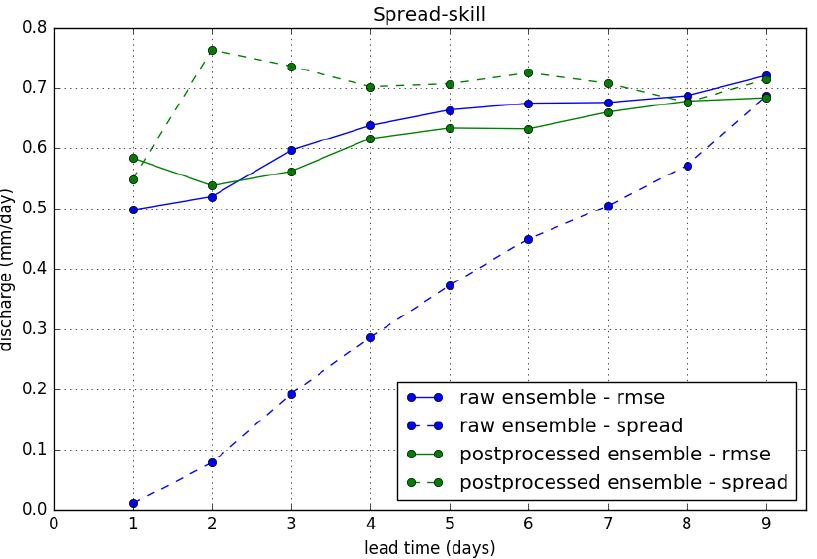
Figure 13. Ensemble spread and RMSE of the ensemble mean during the entire verification period, after truncation of